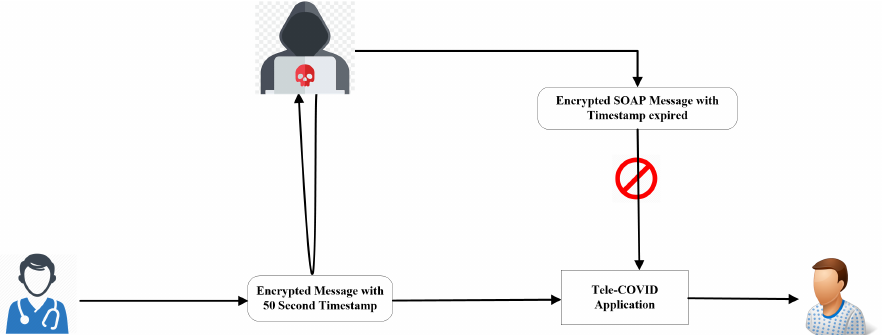
Figure 7. Tele-COVID security mechanism with a